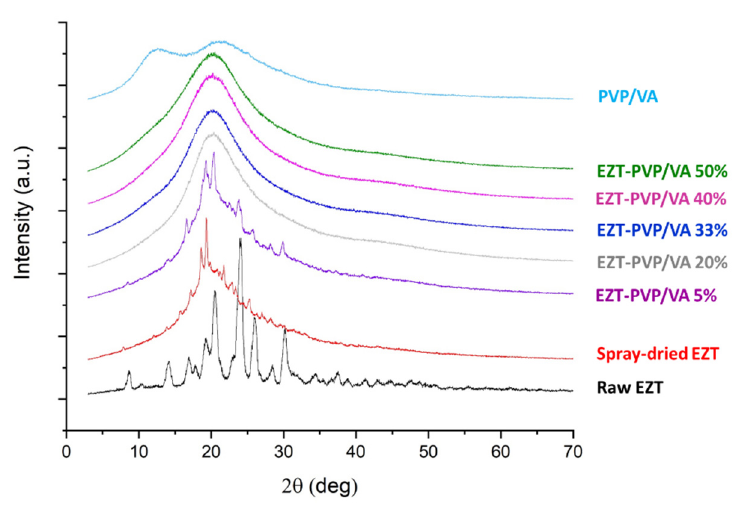
Figure 3. X-ray diffraction patterns of raw and spray-dried ezetimibe, PVP/VA and selected EZT- PVP/VA solid PVP/VA solid dispersions .